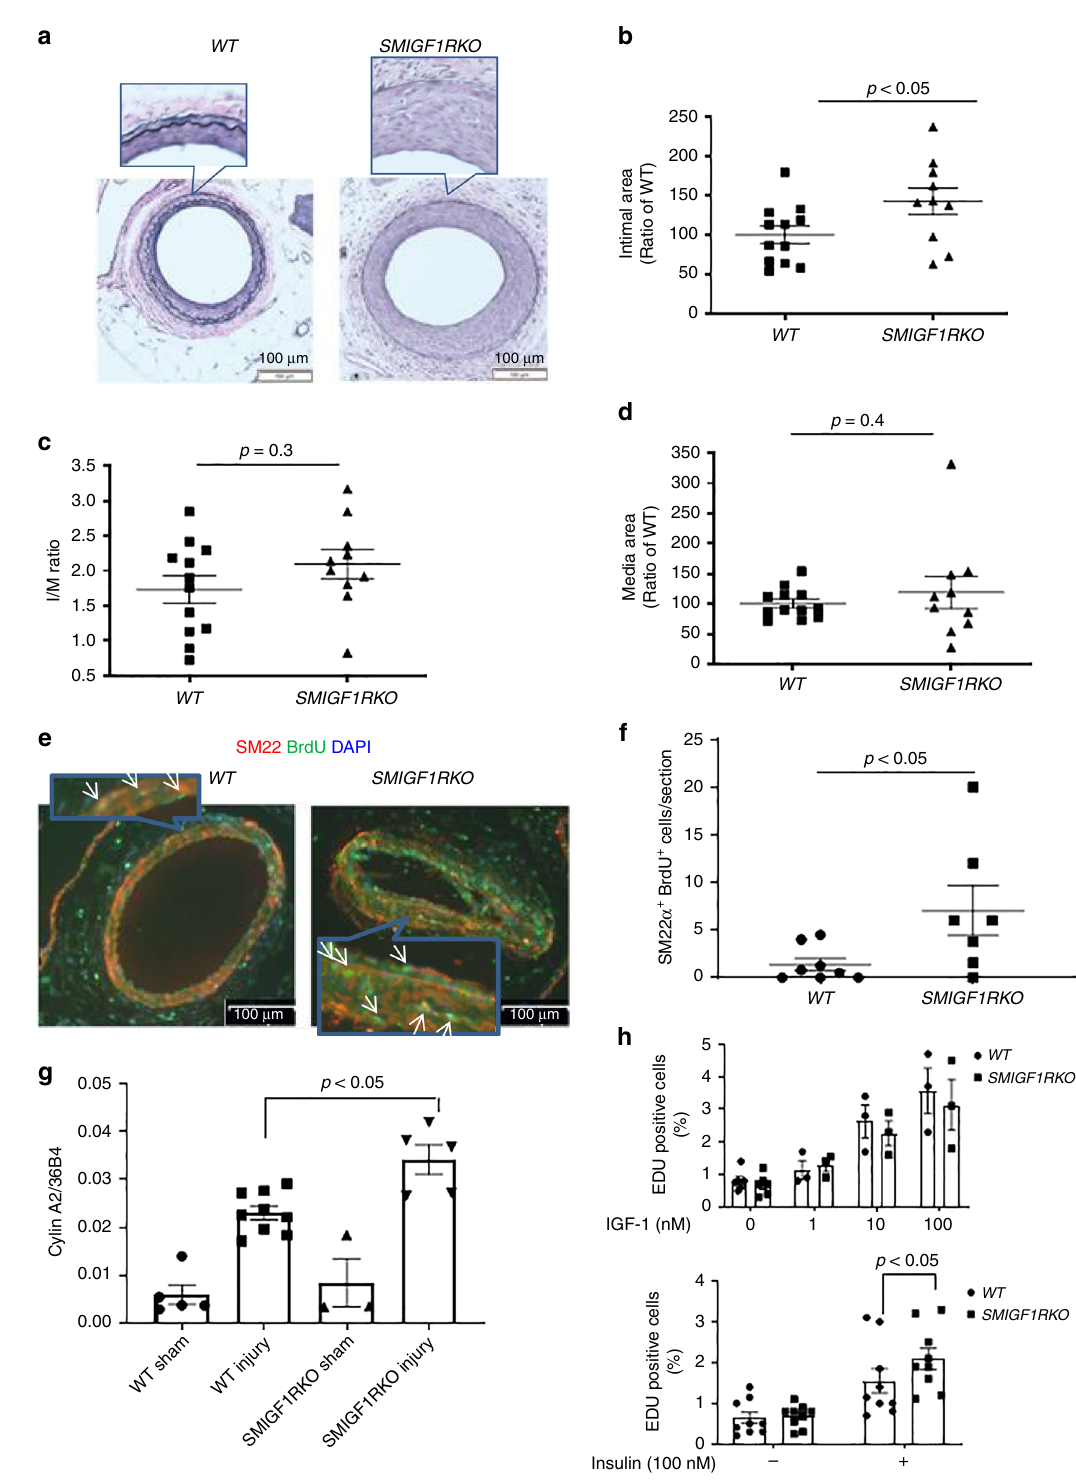
Fig. 2 Wire injury-induced femoral artery intimal hyperplasia in HFD-fed WT and SMIGF1RKO mice. a – d Intimal hyperplasia of femoral artery was determined by elastin staining at 4 weeks after wire injury. a indicates representative images. Summarized intimal area ( b ), intima/media (I/M) ratio ( c ), and media area ( d ) are shown ( WT , n = 12; SMIGF1RKO , n = 10). E-F VSMCs proliferation. The femoral arteries were subjected to wire injury, and then the mice were infused with Brdu with osmotic minipump for 1 week. VSMCs proliferation was determined by SM22 α and Brdu double staining. e indicates representative images, and f shows summarized data ( WT, n = 8; SMIGF1RKO , n = 7). g Cyclin A2 gene expression. Cyclin A2 gene expression in femoral artery at 9 day after wire injury was used as a surrogate marker of cell proliferation, and was determined by qPCR ( WT sham, n = 5; WT injury, n = 9; SMIGF1RKO sham, n = 3; SMIGF1RKO injury, n = 5). h IGF-1 and insulin-induced WT or SMIGF1RKO VSMCs proliferation. Starved VSMCs were stimulated with 1 – 100 nM IGF-1 or 100 nM insulin ( n = 9 for each group) for 24h, and cell proliferation was determined by Edu incorporation and measured by fl ow cytometry. All data from this fi gure are mean± SEM. Two-tailed t test ( b , c , d , f ) or two-way ANOVA with a post hoc test ( g , h ). Source data are provided as a Source Data fi